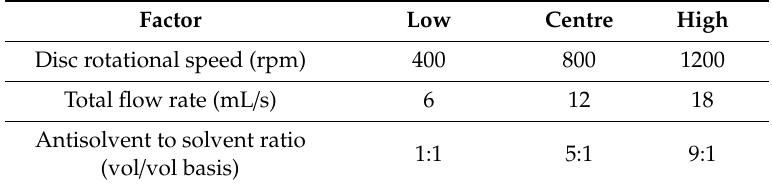
Table 2. Operating conditions for spinning disc reactor (SDR) experiments. Factor Low Centre High Disc rotational speed (rpm) 400 800 1200 Total flow rate (mL / s) 6 12 18 Antisolvent to solvent ratio 1:1 5:1 (vol / vol basis)